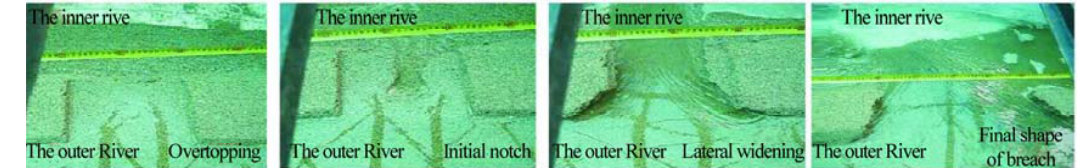
Fig. 9 Development of the levee breach. Fig. 9. Development of the levee breach.